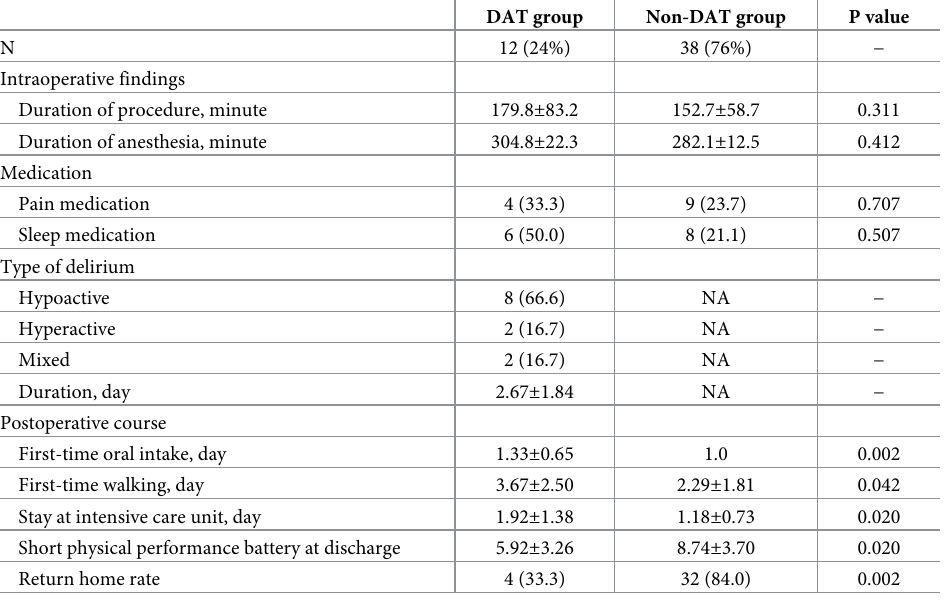
Table 3. Intraoperative and postoperative